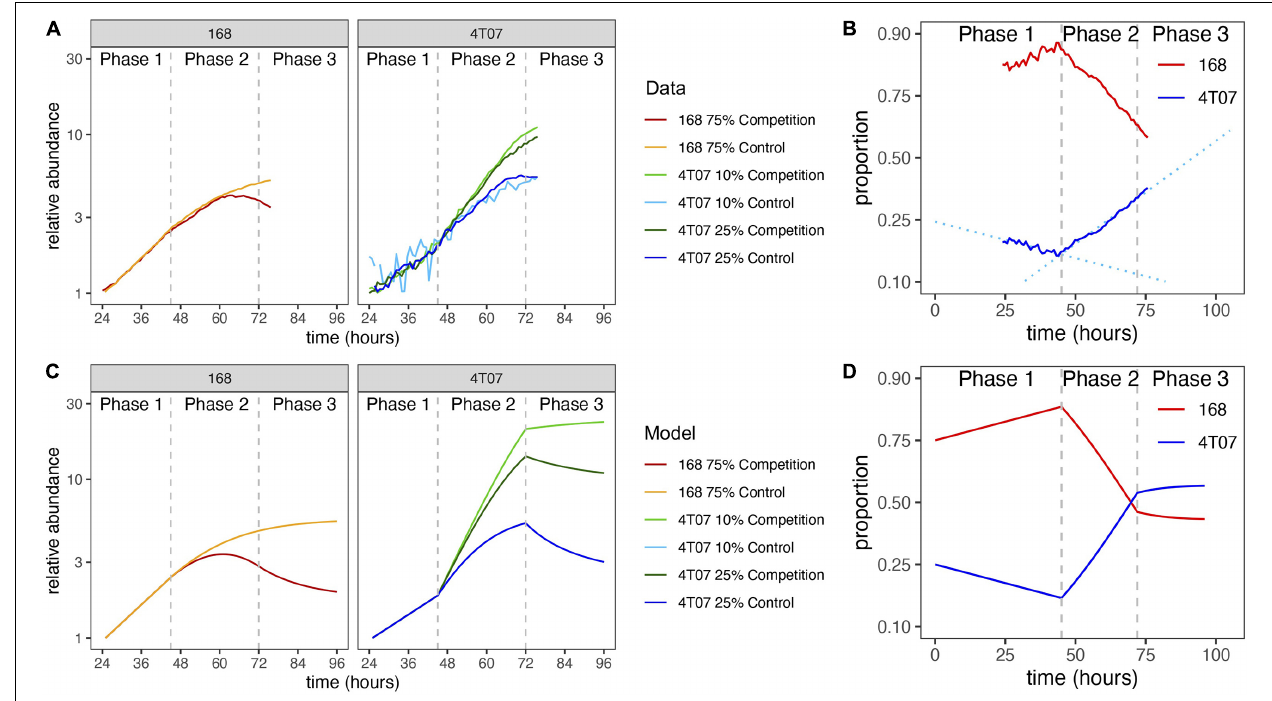
FIGURE 3 | Normalized growth curves of homotypic and heterotypic mixes of subclones. (A) The GFP fluorescence of the labeled subclone was measured by time-lapse microscopy. Cultures were seeded with 10 5 cells per well. Log-transformed data were normalized by fitting regression lines and dividing by the inferred value at 24 h. Vertical dashed lines mark the start of phase 2 (45 h) and phase 3 (72 h). (B) Frequency dynamics. Curves obtained by combining the results of two competition experiments: one with labeled 4T07 and the other with labeled 168. The initial 4T07 proportion was 25% in both cases. The vertical axis is logit-transformed so that the slope of each curve is equal to the difference in net growth rates at the corresponding time (see section “Materials and Methods”). Dotted regression lines are shown to draw attention to the change of slope. (C) Normalized growth curves according to mathematical model with parameter values inferred from data. The model is described in section “Materials and Methods” and parameter values are given in Table 1 . (D) Frequency dynamics according to mathematical model with parameter values inferred from